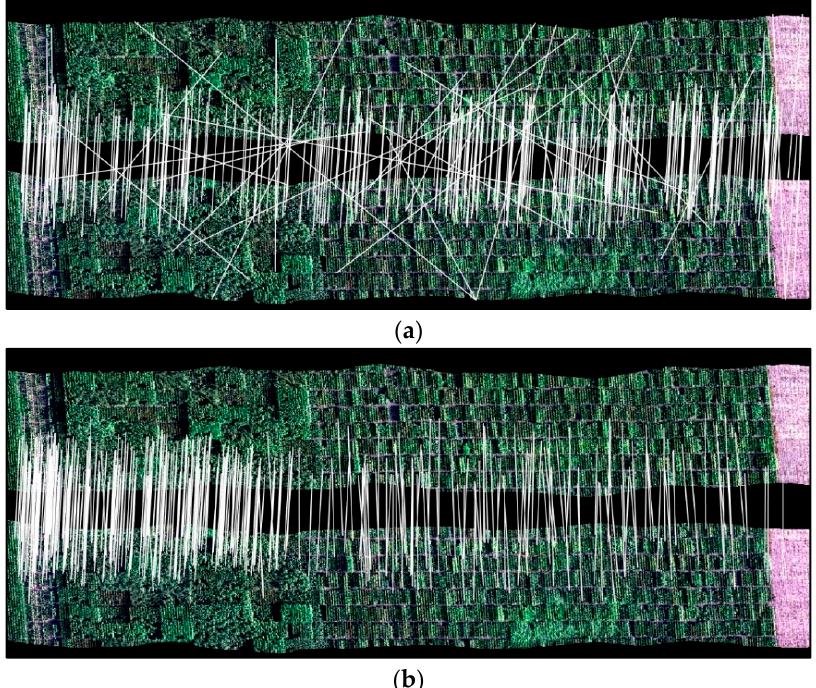
Figure 5. Comparison of the matching performance for acquired imagery over an agricultural field: ( a ) SURF and ( b ) modified SURF strategies.